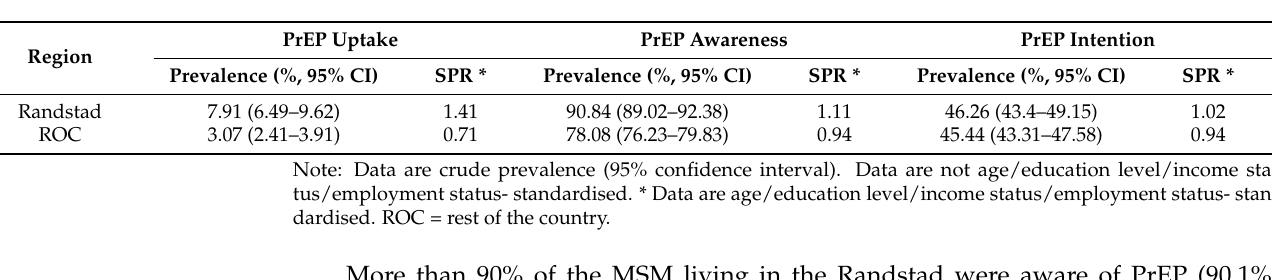
Table 2. Estimated prevalence and standardised prevalence ratio, Randstad vs. the rest of the country (ROC),